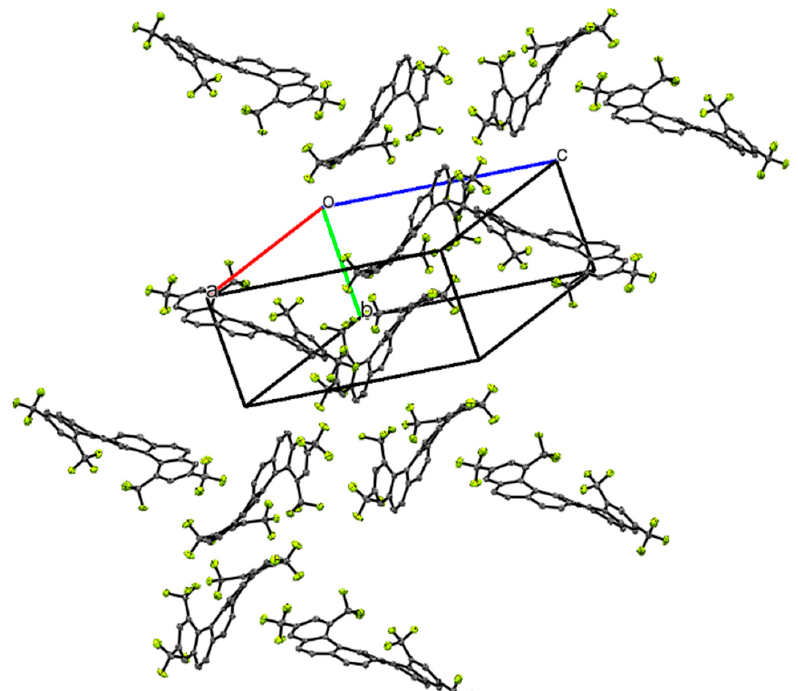
Figure 4. Molecular packing of the compound 4b along with a-axis, slightly bent towards front (thermal ellipsoids are drawn on 50% probability level). Pale green ellipsoid represents F atoms.